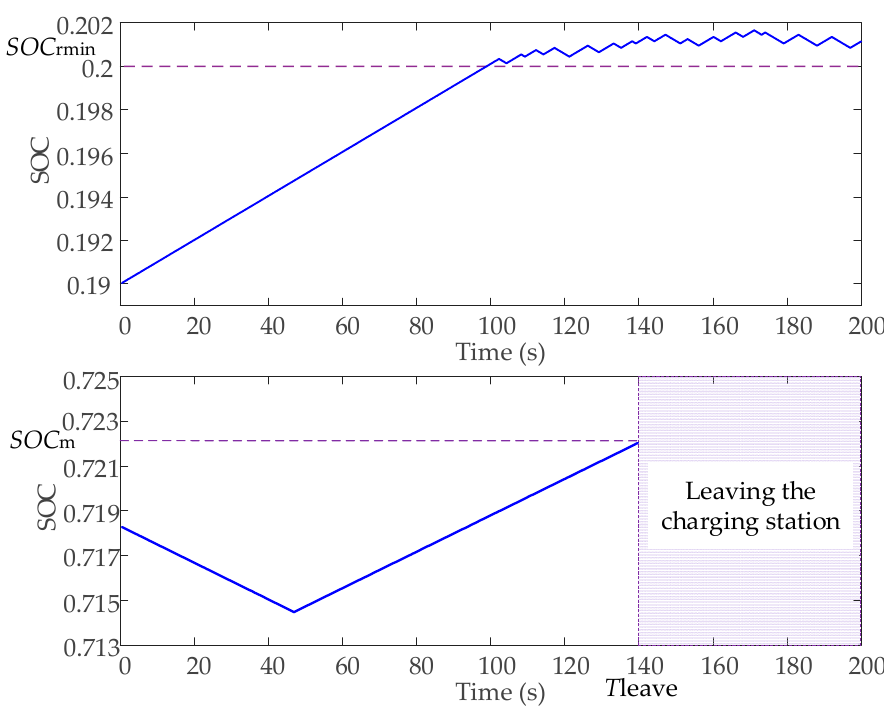
Figure 10. Changes of SOC of EVs at critical value.